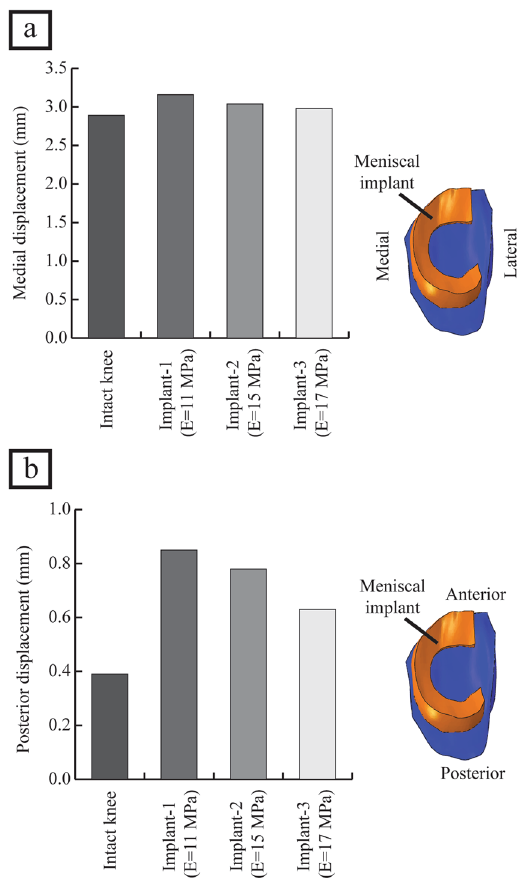
Figure 4. ( a ) The medial displacement of the meniscus or implant induced by the intact knee and the knee joint with the meniscal implant with three distinct material stiffness, and ( b ) the posterior displacement of the meniscus or implant induced by the intact knee and the knee joint with the meniscal implant with three distinct material stiffness, loaded with an axial compressive joint load of 1150 in meniscal implant material stiffness affected the cartilage contact pressures and implant displacement, and (3) increasing the material stiffness of the meniscal implant increased the cartilage contact pressures, but reduced the implant displacement.